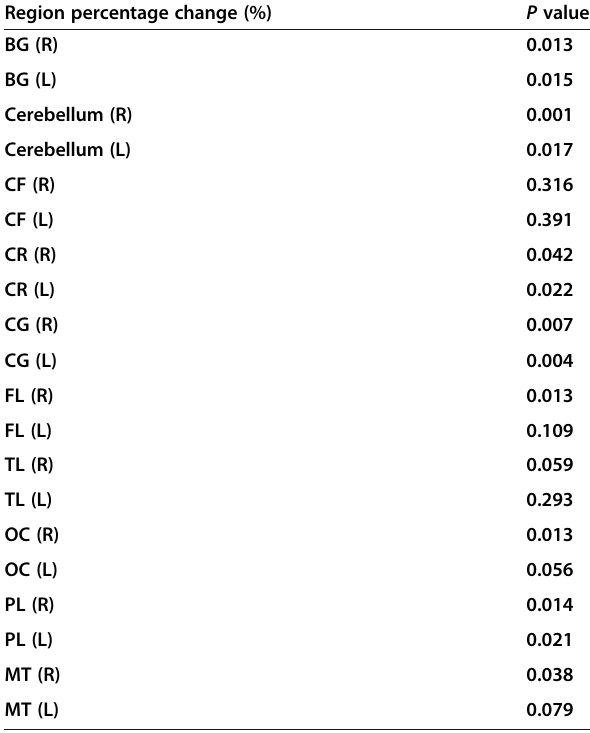
Table 4 The correlation between percentage change of the above-examined regions and the time interval in weeks Region percentage change